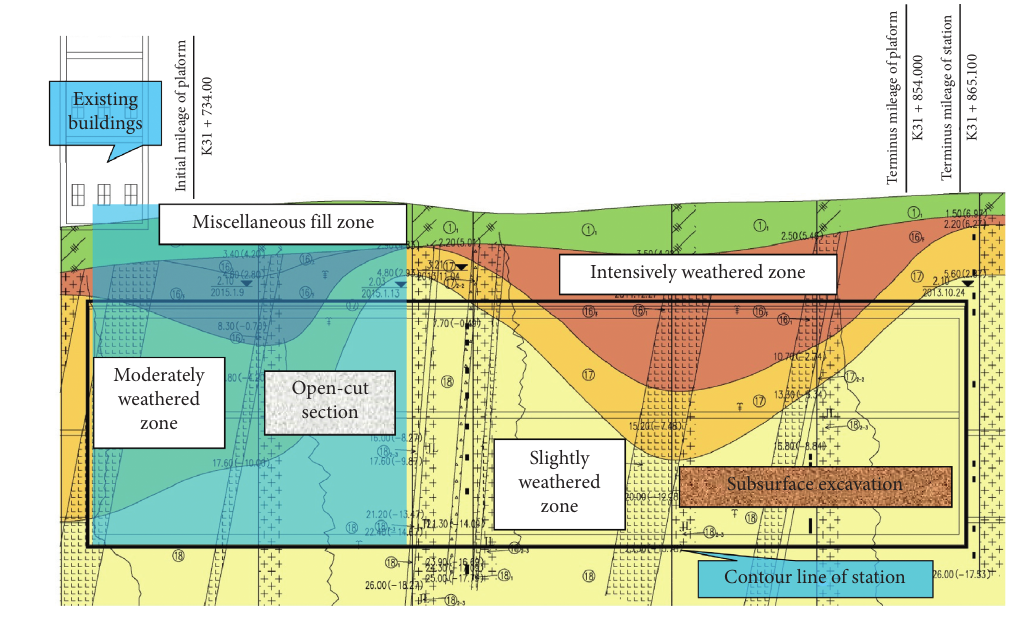
Figure 1: Geological profile of the Haichuan Road metro station.